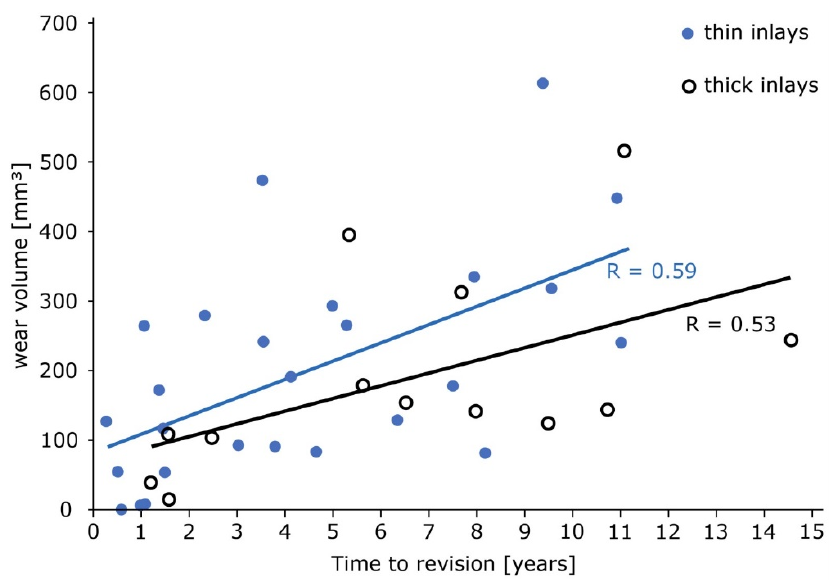
Figure 8. Thin and thick inlays show comparable wear volumes over time (p = 0.196).